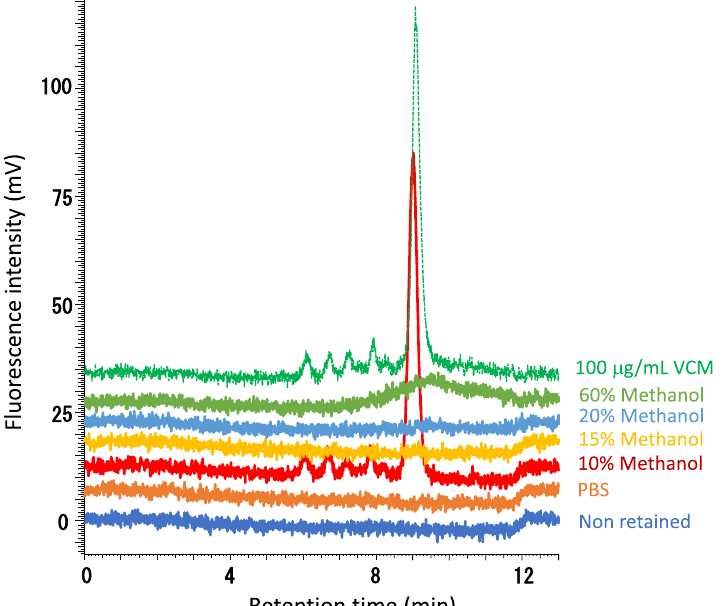
Fig. 1 Chromatograms of fractionates and 100 μg/mL VCM solutions. Column: Resolve 5-µm spherical C18 column (3.9 mm phase A: 20-mM formic acid/ammonium formate, B: 100% methanol, gradient program: 5–10% (B) from 0 to 5 min, flow rate: 1 mL/min, detection: fluorometry (ex/em. 290/330